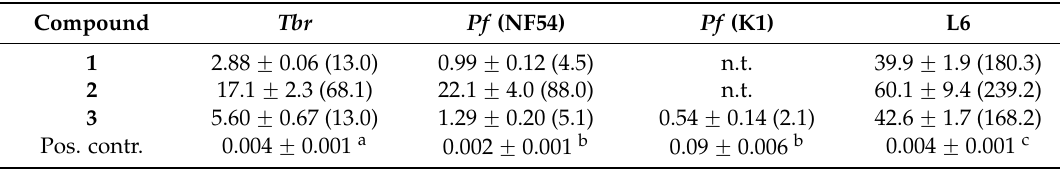
Table 4. In vitro antiparasitic activity IC 50 values in µ g/mL and cytotoxicity (L6 rat skeletal myoblasts) of alkamides 1 – 3 . Mean values are also reported in µ M (in brackets) for easier comparison between compounds.